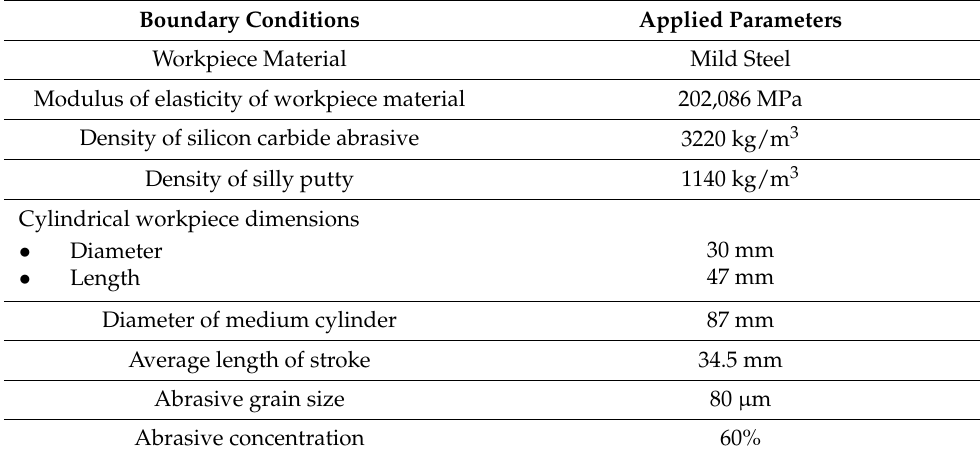
Table 14. The validation of the CFD tool [247].